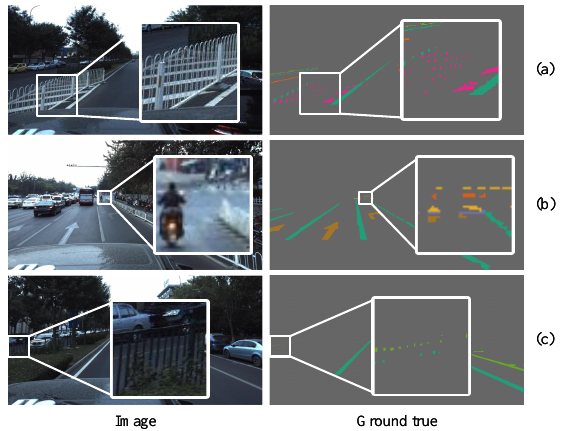
Figure 7. The annotations of the Apolloscape lanemark segmentation dataset are very accurate. ( a ) Safety zone warning lines in fence gaps; ( b ) tiny targets in the distance, including turning arrows, zebra crossings, stop lines, and single solid lines; ( c ) single solid lines of opposite lanes and border lines of parking areas obscured by railings.